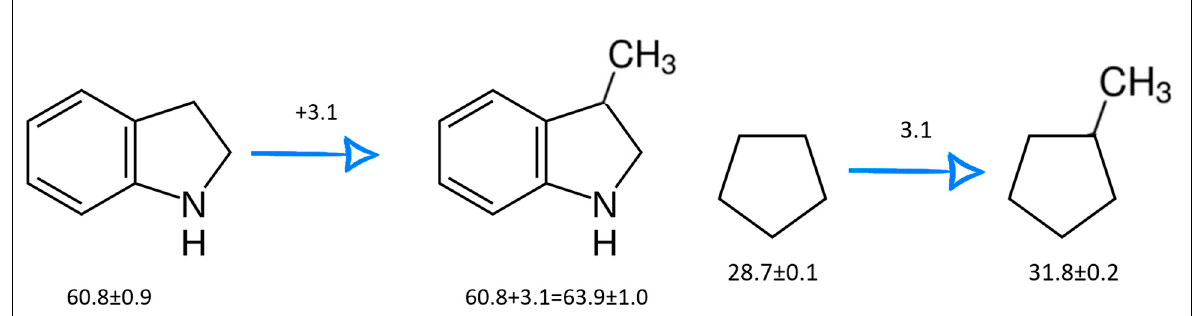
Figure 3. Left: application of the “centerpiece” approach to estimate the vaporization enthalpy of 3-methyl-indoline from the reliable enthalpy of vaporization of indoline [3]. Right: estimation of the CH 3 -contribution from vaporization enthalpies of methyl-cyclopentane [40] and cyclopentane [40]. Numerical values are given in kJ·mol − 1 at T = 298.15 K.